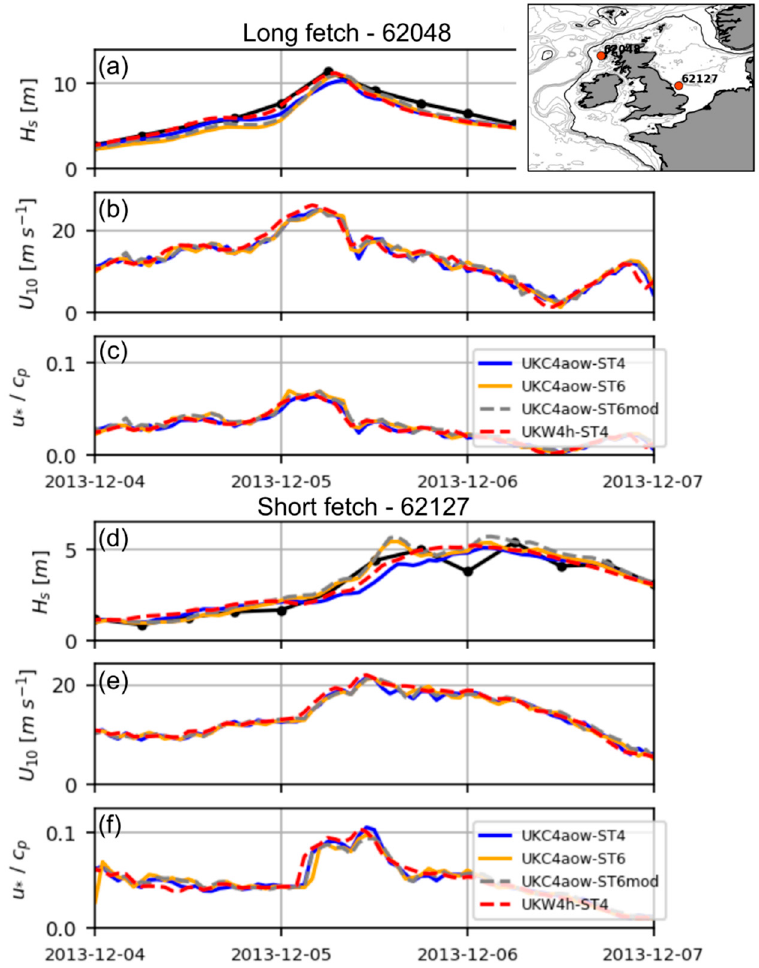
Figure 6. Timeseries of modelled ( a , d ) significant wave height ( H s ), ( b , e ) wind speed ( U 10 ) and ( c , f ) inverse wave age ( u ∗ / c p ) for long (62048) and short (62127) fetch locations during storm Xaver. Observed in-situ H s are also presented in ( a , d ). The exact position for the specific locations is specified in the right corner inset.